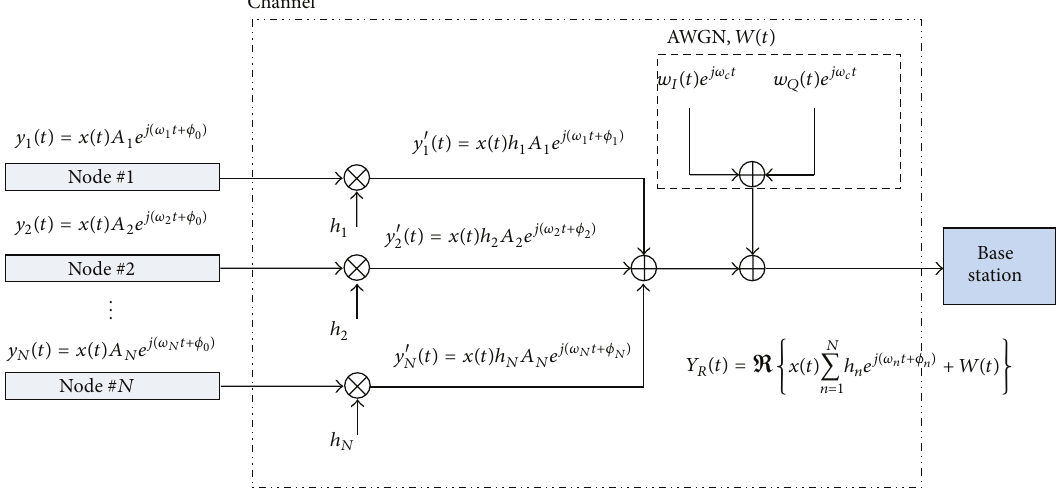
Figure 2: Mathematical model of wireless networks employing a distributed